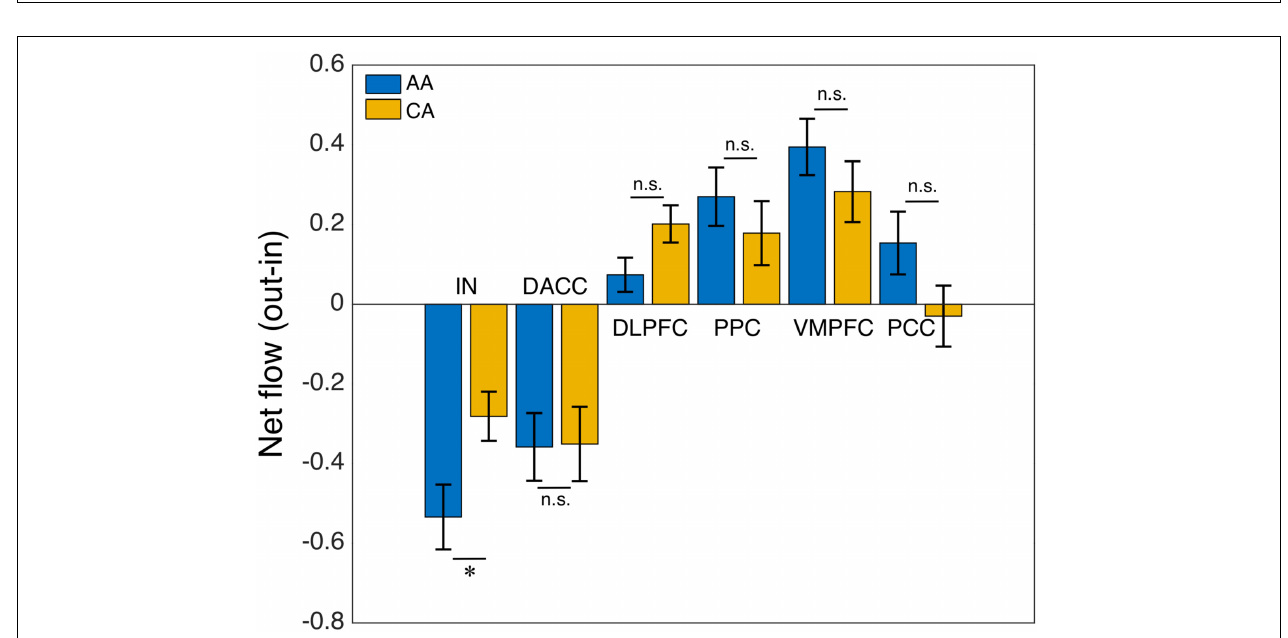
FIGURE 3 | African–Americans (AA) versus Caucasian–Americans (CA) comparison: net flow (out-in) of the key nodes of the salience (IN, insula; DACC, dorsal anterior cingulate cortex), central-executive (DLPFC, dorsolateral prefrontal cortex; PPC, posterior parietal cortex) and default-mode (VMPFC, ventromedial prefrontal cortex; PPC, posterior cingulate cortex) networks. The AI of AA group had a significantly lower net flow (out-in) compared with that of CA group ( ∗ indicates statistical significance; ns indicates not significant).